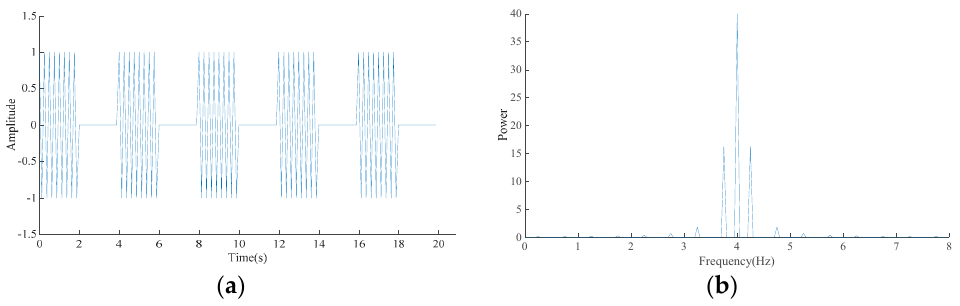
Figure 3. Simple pulse characteristic diagram: ( a ) time distribution; ( b ) frequency domain.